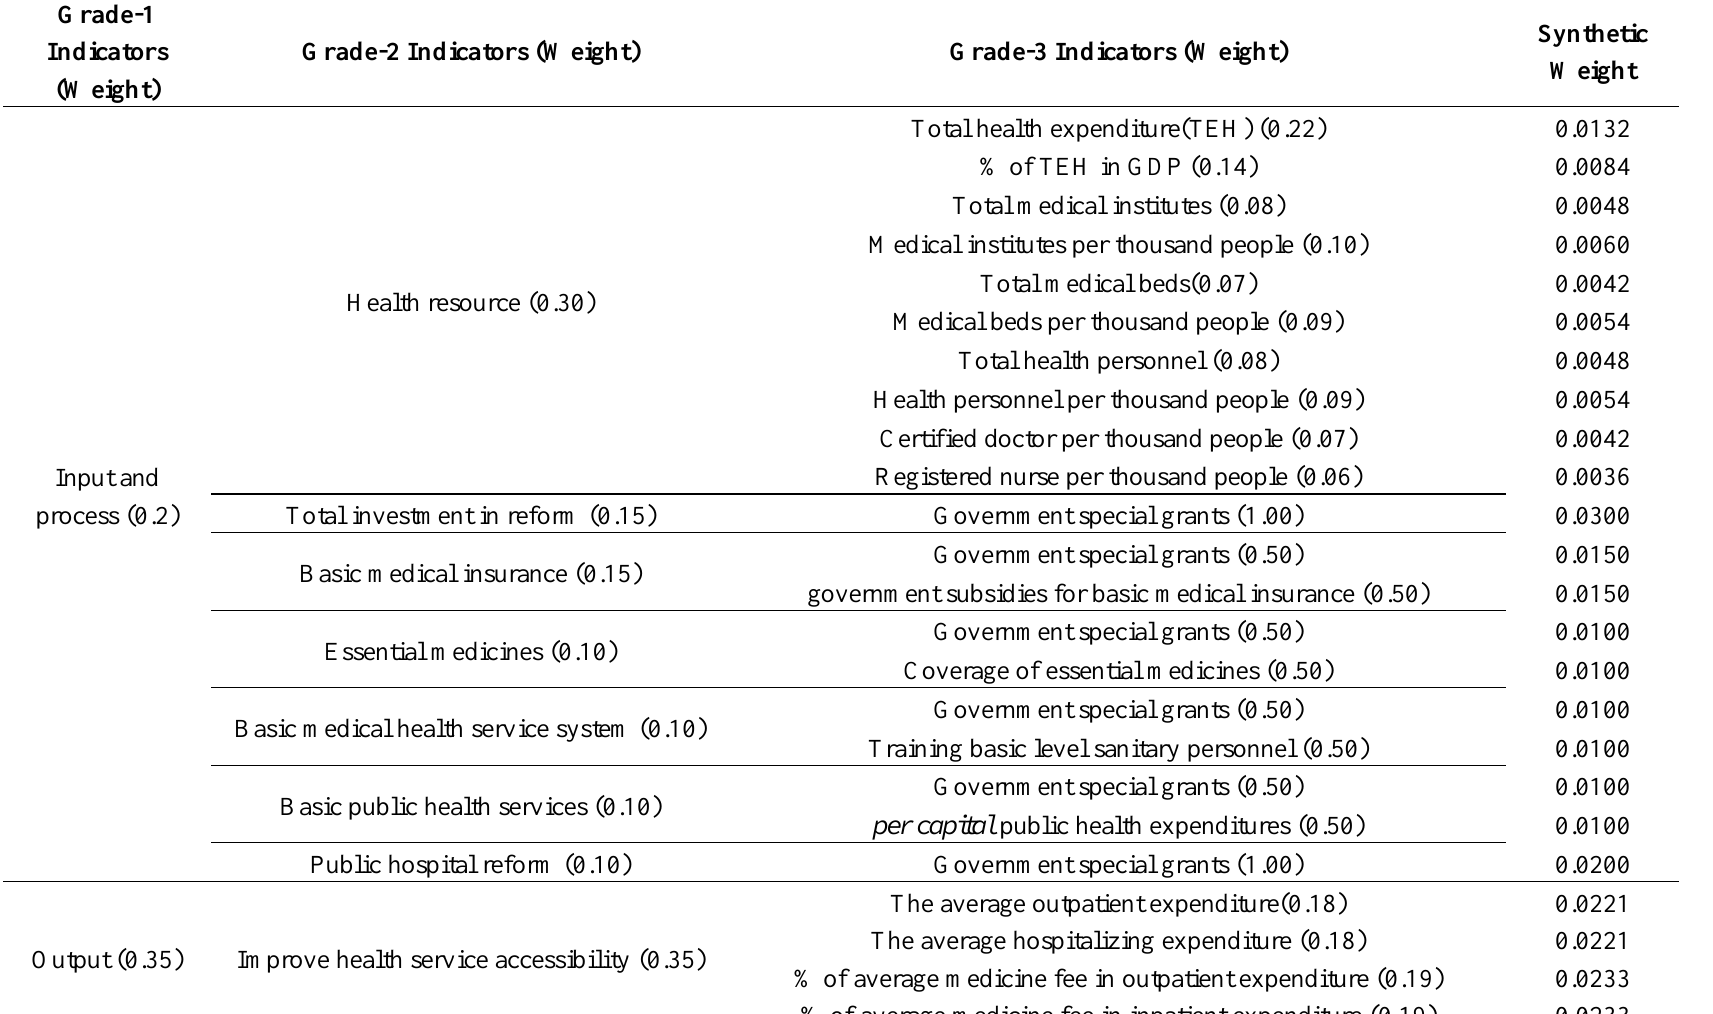
Table 1. Indicator system for